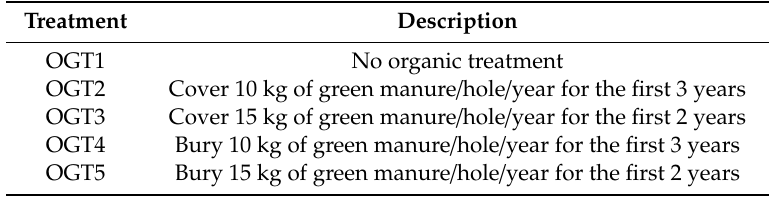
Table 2. Organic treatments to improve soil organic matter and physical